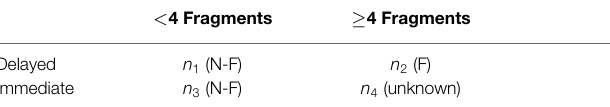
TABLE 6 | Criteria 5 (C5)